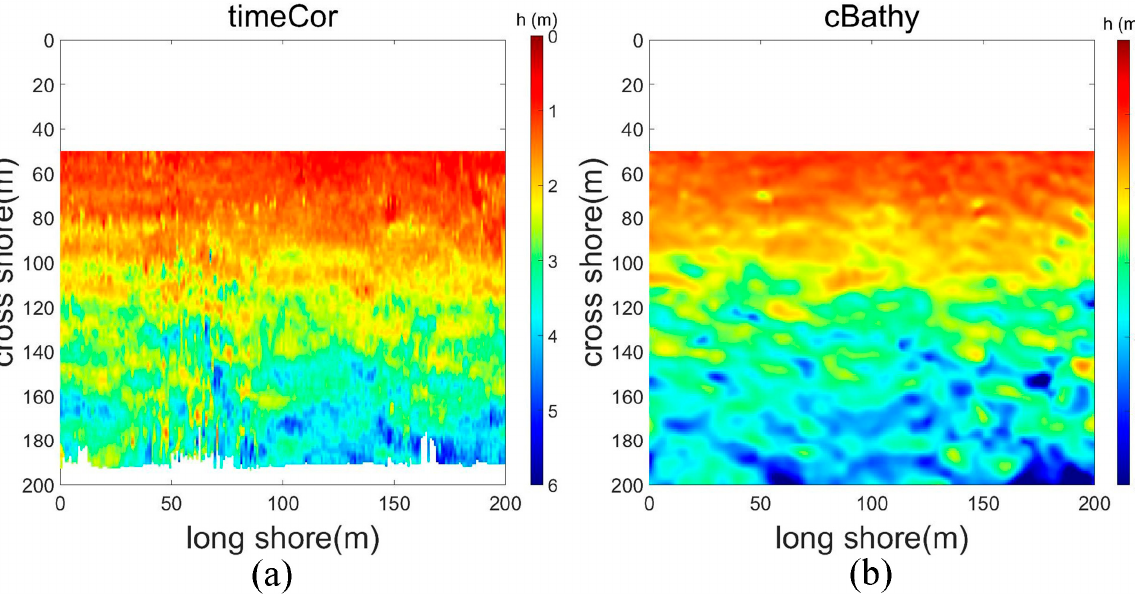
Figure 18. Bathymetry results of timeCor ( a ) and cBathy ( b ).